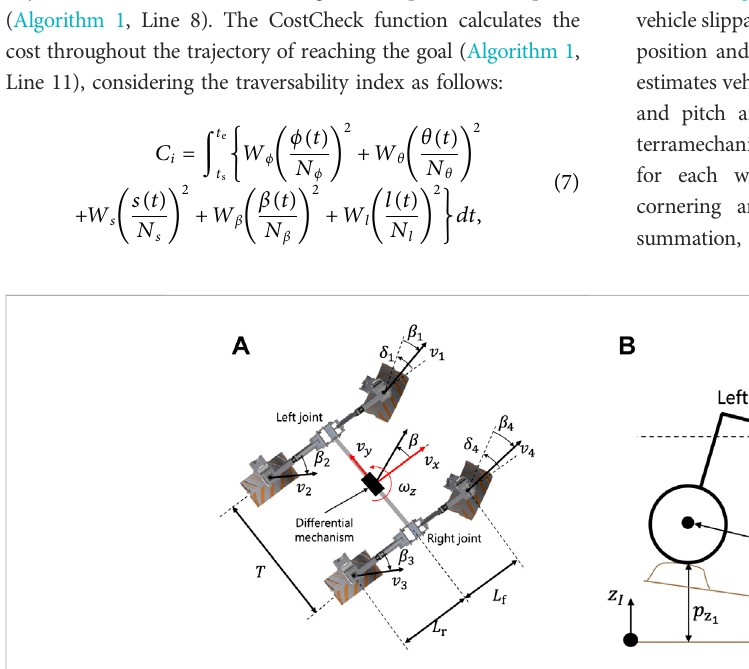
FIGURE 4 Schematic view of the vehicle model with a differential suspension. (A) Top view, (B) Side